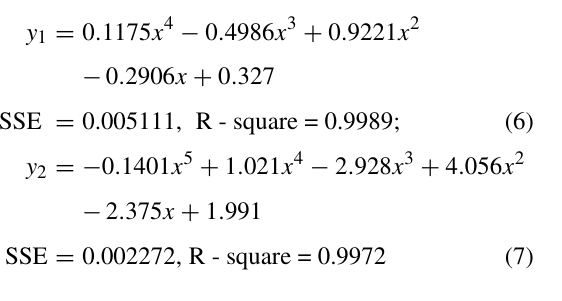
Fig. 4. Outer contour polynomial fitting